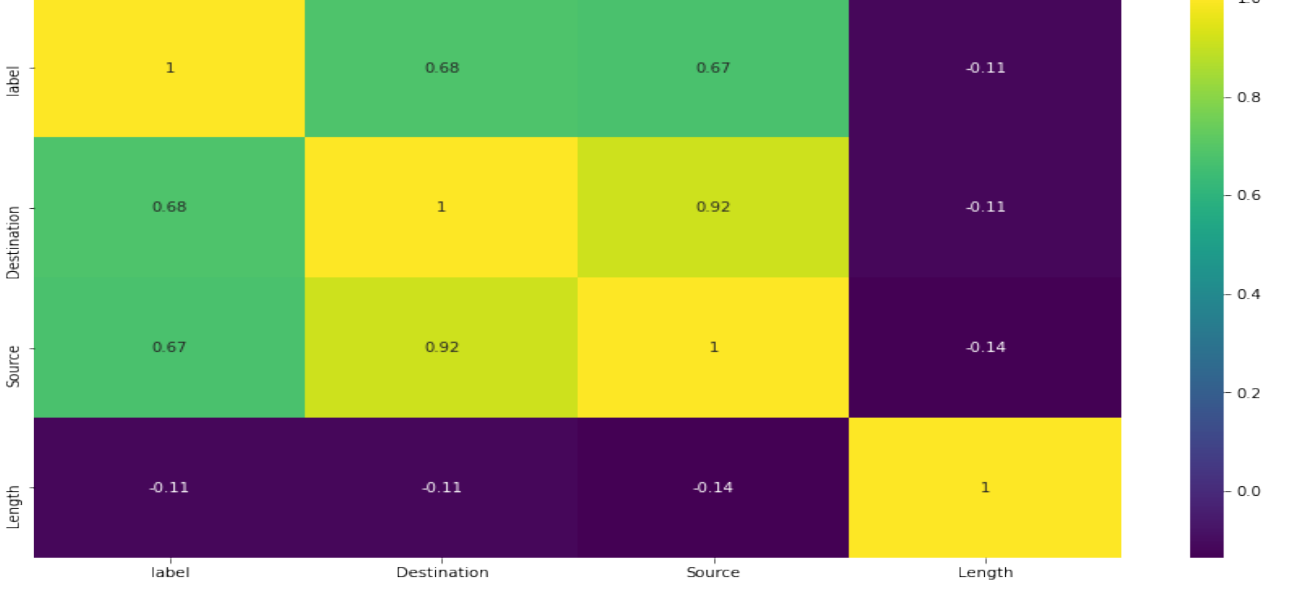
Table 13. Sensitivity analysis of ML using binary classification.